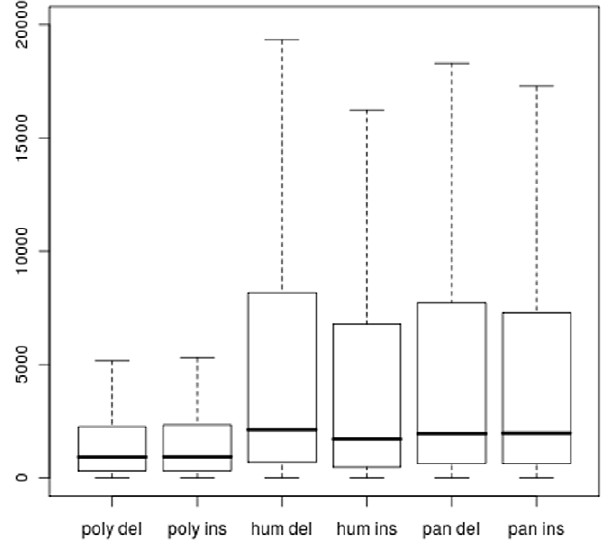
Figure 4. Distance to closest coding region. Boxplots of distance to the closest coding region of polymorphic deletions (‘‘poly del’’, n=4350), polymorphic insertions (‘‘poly ins’’, n=1831), fixed human deletions (‘‘hum del’’, n=5824) , fixed human insertions (‘‘hum ins’’,